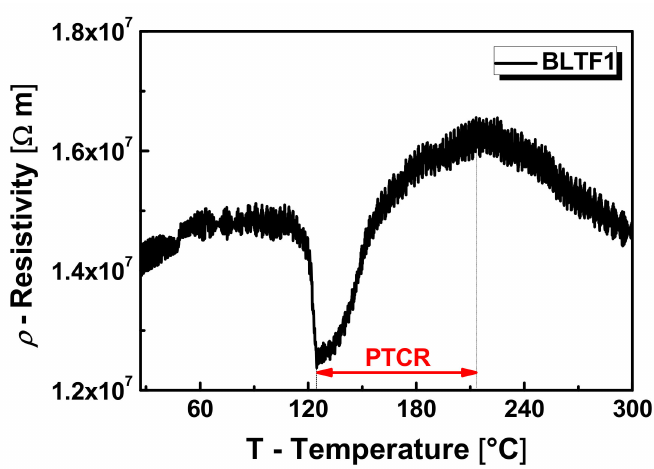
Figure 7. Temperature dependence of conductivity characteristic for BLTF ceramics.